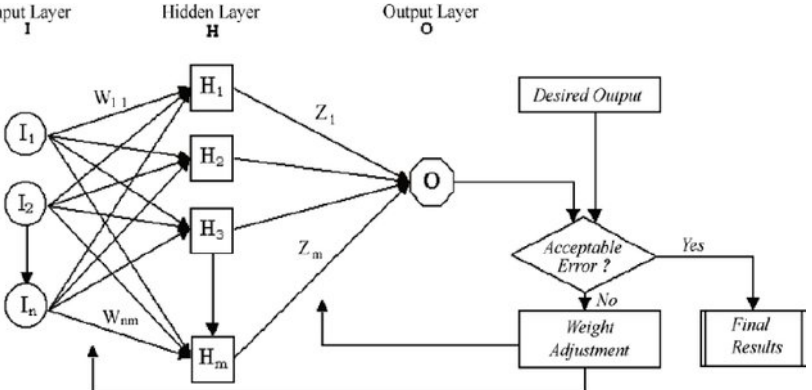
Figure 1. MLP network structure (Source: Khalafi and Mirvakili 2011).